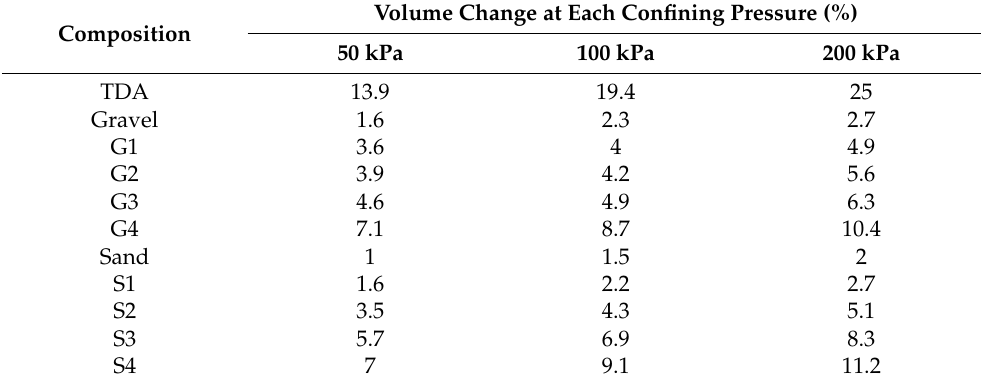
Table 2. Volume change of samples during the consolidation stage.